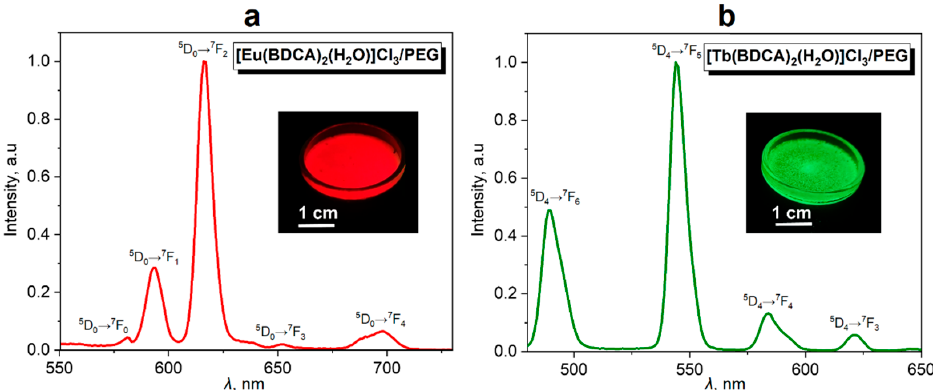
Figure 5. PL emission spectra of [Eu(BDCA) 2 (H 2 O)]Cl 3 ( a ) and [Tb(BDCA) 2 (H 2 O)]Cl 3 ( b ) encapsu-